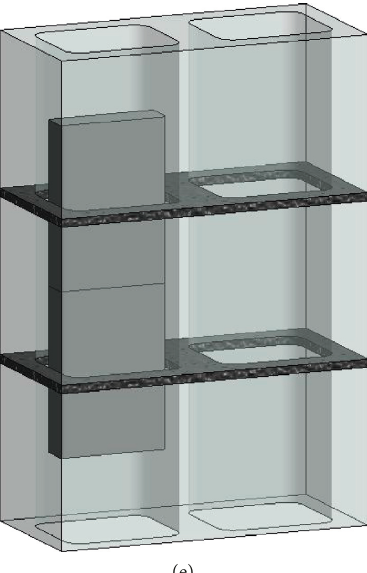
Figure 6: Schematic diagram of five test groups. (a) Group CO. (b) Group PB-H/2. (c) Group PB-H/3. (d) Group PB-H/4. (e) Group PB-B/3.